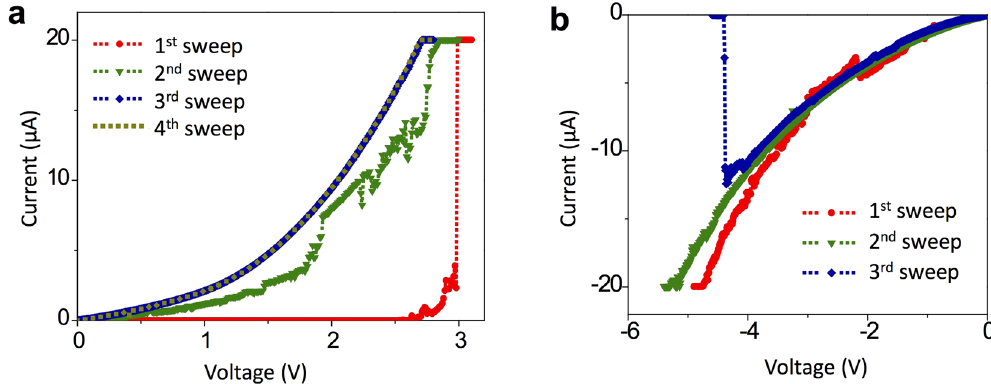
Figure 2. ( a ) I-V profiles for an electroforming process of a pristine cell in the new configuration (Pt/TiO 2 coated tip in contact with a Pt substrate) followed by three potentiodynamic sweeps. Anodic biases were applied to the Pt substrate. ( b ) I-V profiles obtained by applying cathodic biases to the Pt substrate after the fourth sweep shown in ( a ). All the sweeps were performed by having the tip on a specific location of Pt substrate without detaching the tip off the